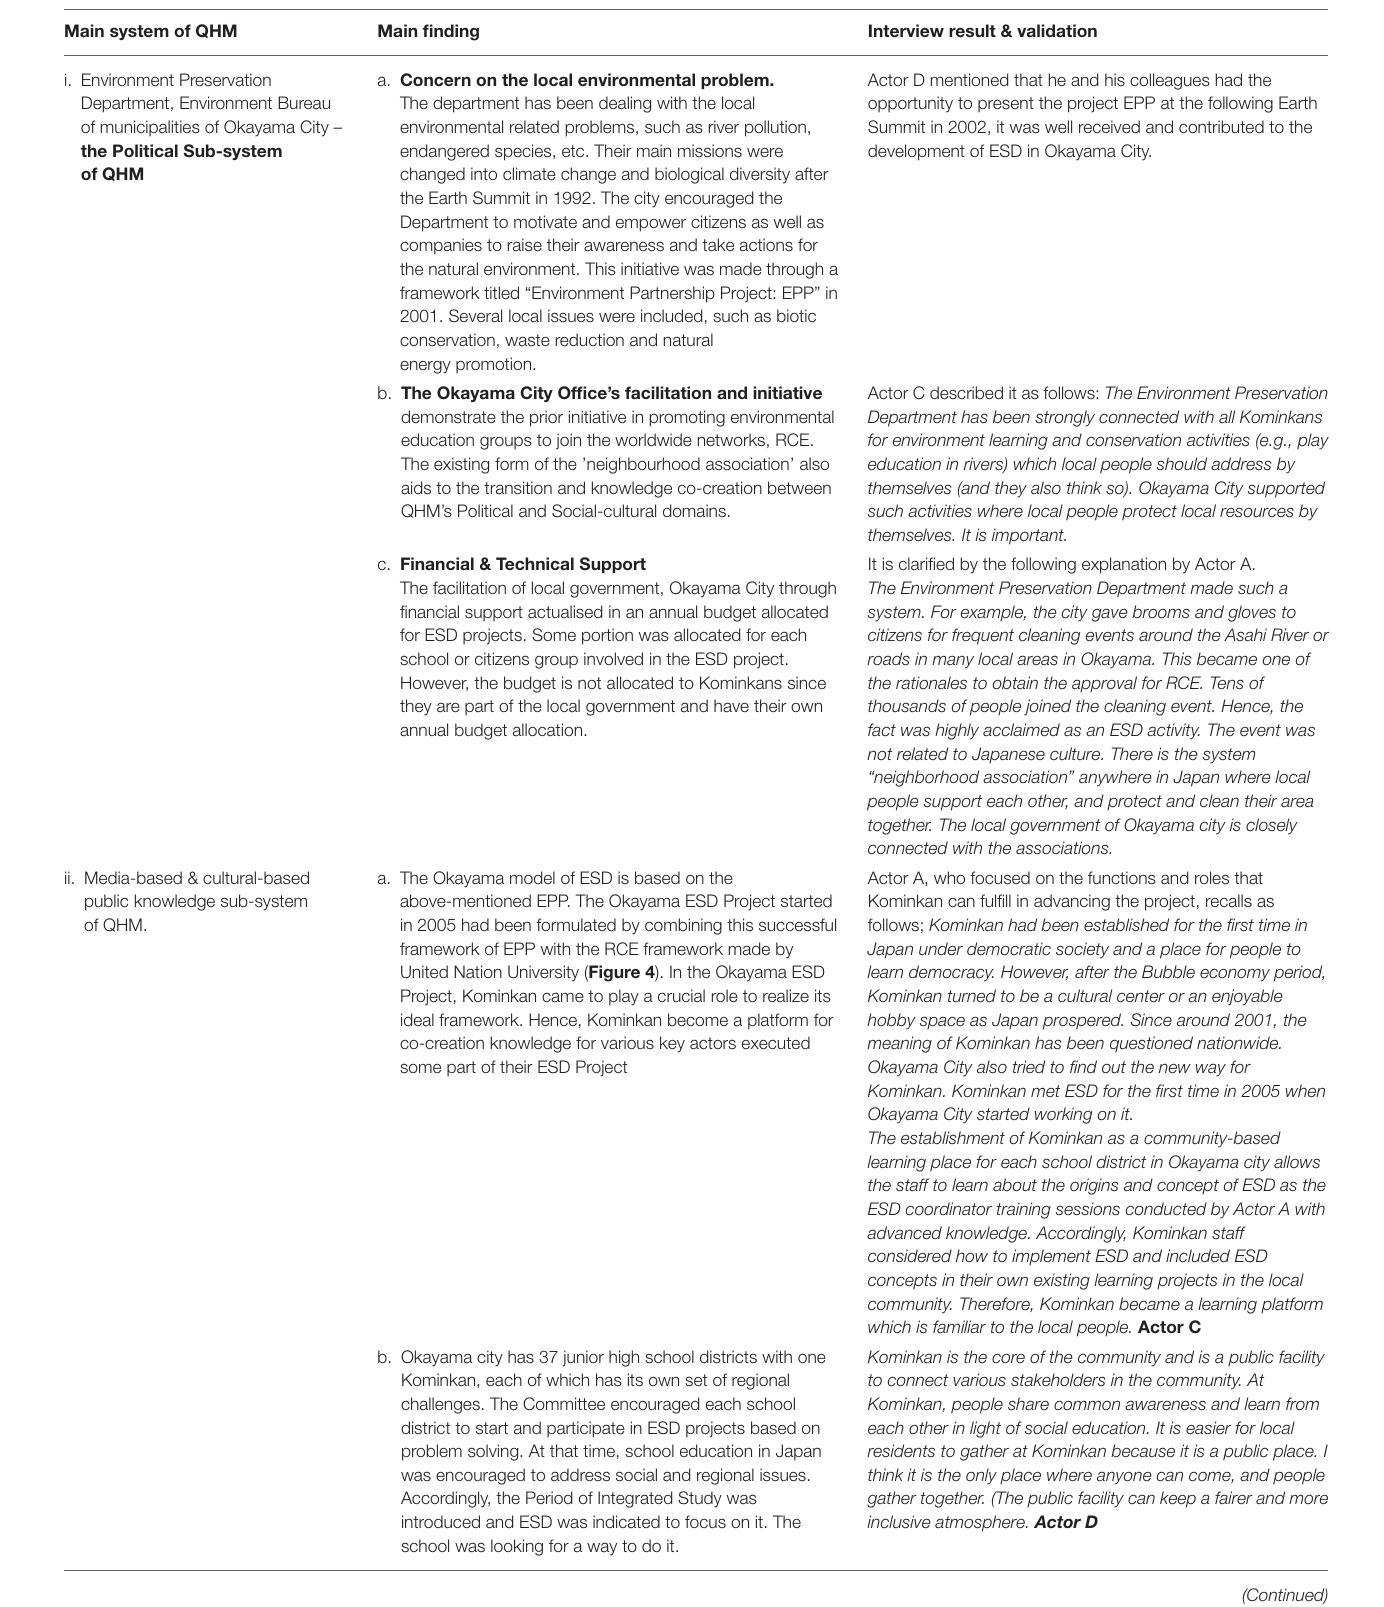
TABLE 2 | Synthesis main finding of Okayama model of ESD from the QHM